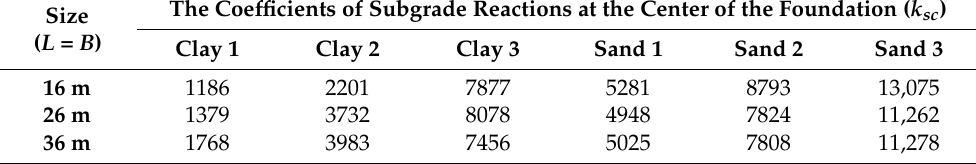
Table 3. The coefficients of subgrade reactions obtained at the center of the foundation.